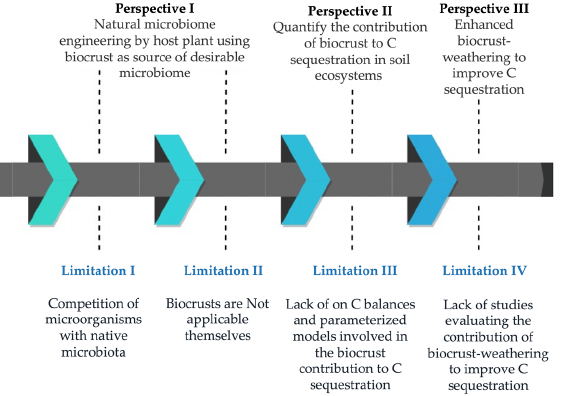
Figure 2. Proposal perspectives to solve practical limitations to the use of biocrusts for increased carbon sequestration.